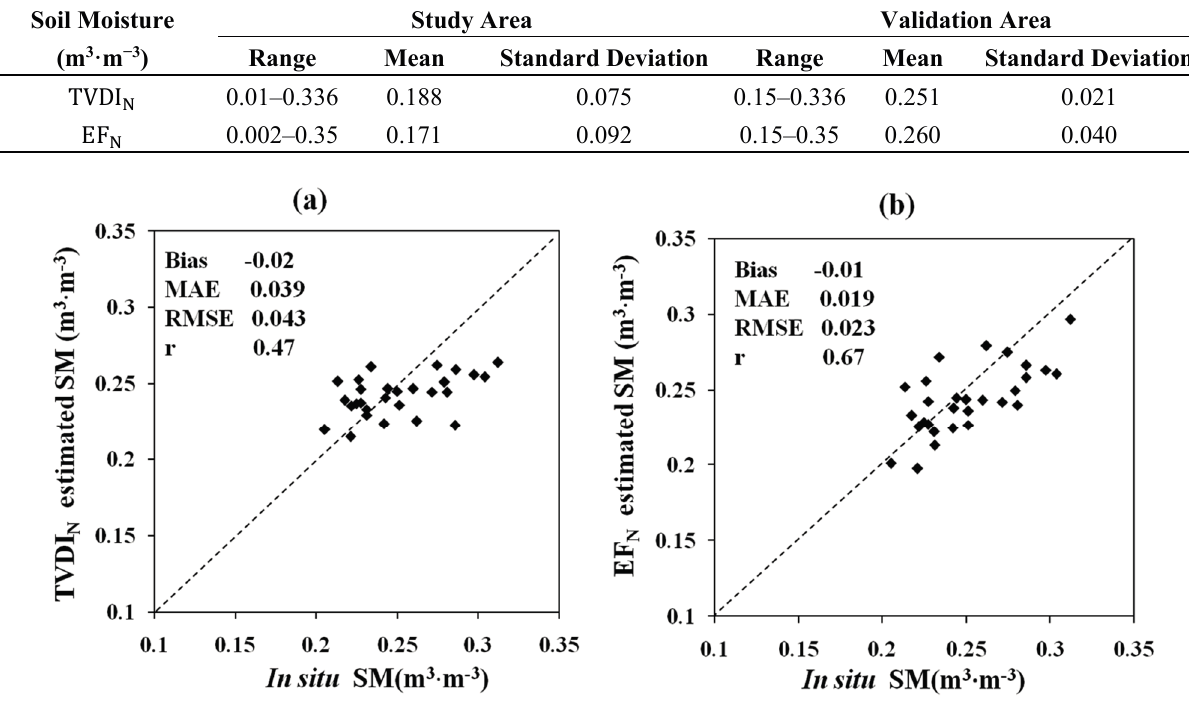
Table 5. Statistical analysis of the SM content from TVDI Soil Moisture